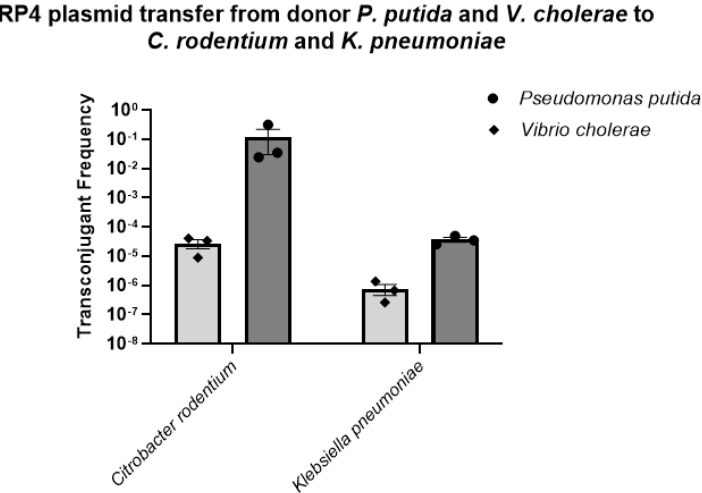
Figure 5. Transfer frequencies of the BHR RP4 plasmid from donors Pseudomonas putida and Vibrio cholerae to recipient coliform bacteria Citrobacter rodentium and Klebsiella pneumoniae . The plasmid transfer frequencies for all recipients were calculated using the formula (plasmid transfer frequency = transconjugants/(transconjugants + recipients)). Bars show mean values ± standard error of the mean (SEM) based on three independent replicates (n = 3) performed for each conjugation experiment.